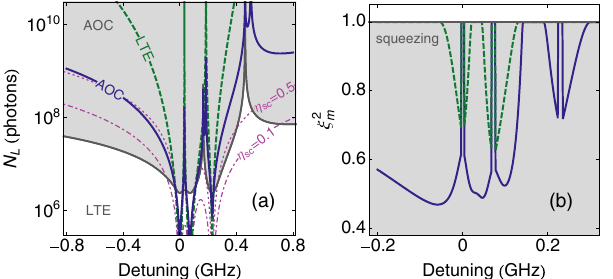
FIG. 4. Theoretical comparison of AOC (solid blue curves) and LTE (dashed green curves) measurement sensitivity. (a) Number of photons N L needed to achieve projection-noise-limited sensi- ˆ J Þ 2 ¼ ð Δ ˆ J Þ 2 ¼ N = 4 as a function of detuning Δ . tivity ð Δ y y A LTE AOC ˆ J Þ 2 ¼ ð Δ ˆ J Þ 2 The gray line indicates ð Δ , so that the AOC y y LTE AOC (LTE) strategy is more sensitive in the shaded (white) region. ¼ 0 . 1 (dot – dashed curve) Magenta curves represent damage η sc and 0.5 (dotted curve) to the atomic state due to spontaneous emission. (b) Estimated metrologically significant spin squeezing ξ 2 N L , versus probe m , optimized as a function of